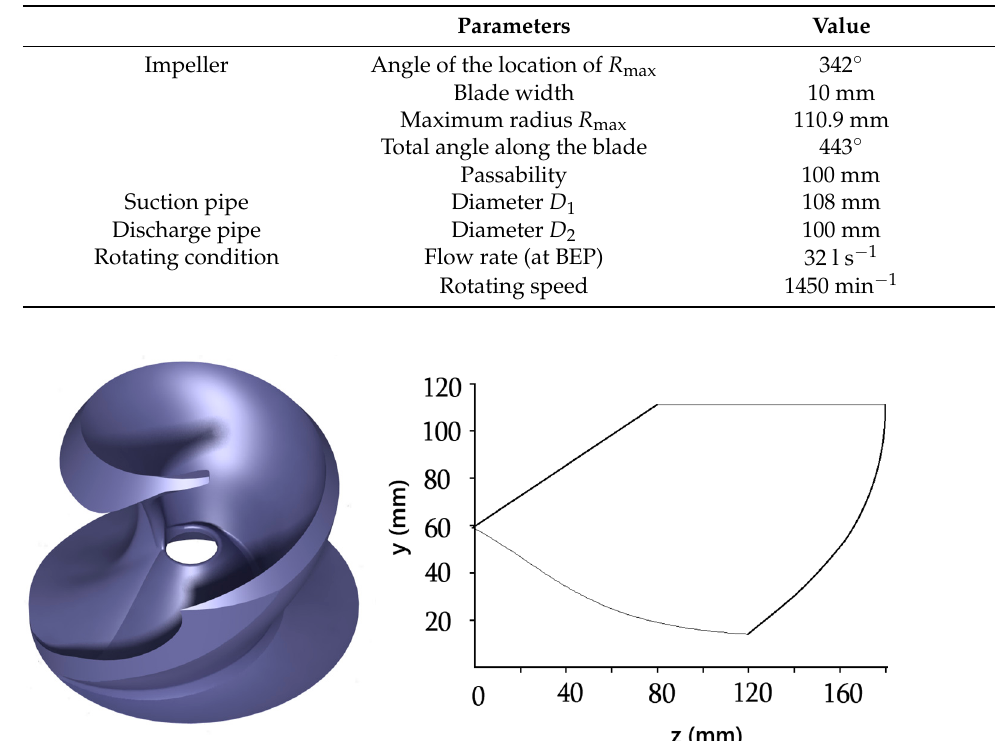
Table 1. Specifications of the single blade centrifugal pump.